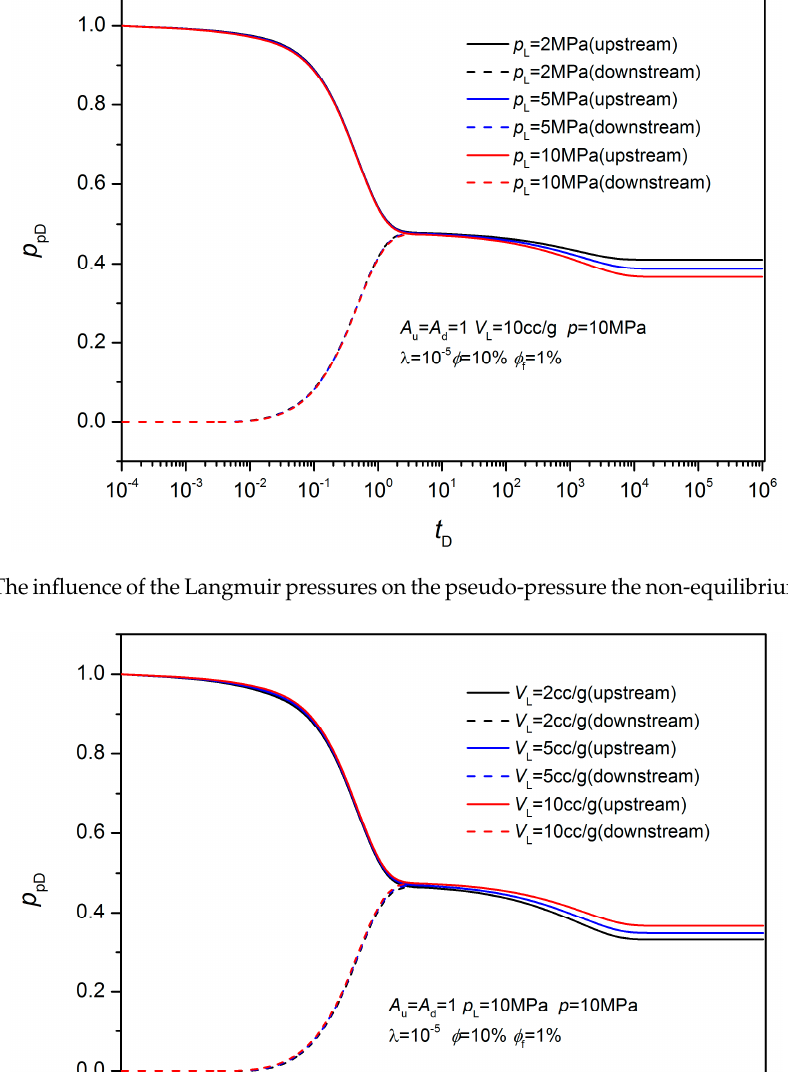
Figure 7. The influence of the testing pressure on the curve of the non-equilibrium sorption model.